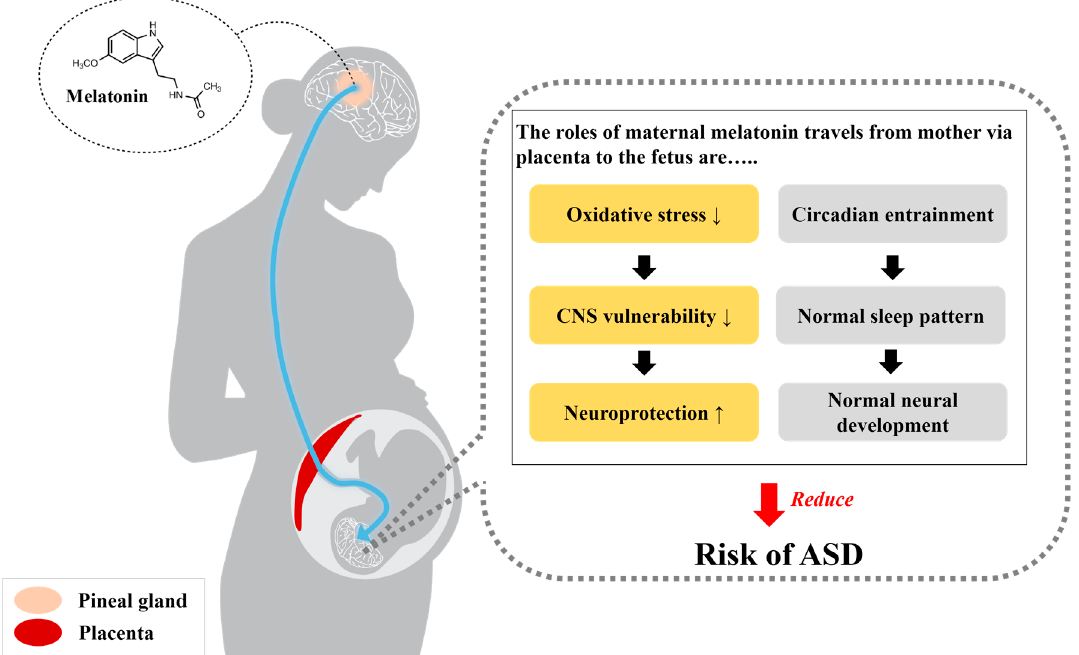
Figure 2. The beneficial roles of maternal melatonin that travels from mother via placenta to the fetus. The functions of melatonin in neuroprotection and circadian entraining may reduce the risk of ASD. Normal melatonin concentrations during pregnancy contribute to neuroprotection and the normal neurodevelopment of the fetus through the inhibition of excessive oxidative stress in the vulnerable central nervous system. Additionally, as adequate melatonin levels maintain the normal sleep pattern and circadian rhythm, normal melatonin secretion may also elicit neurodevelopment.